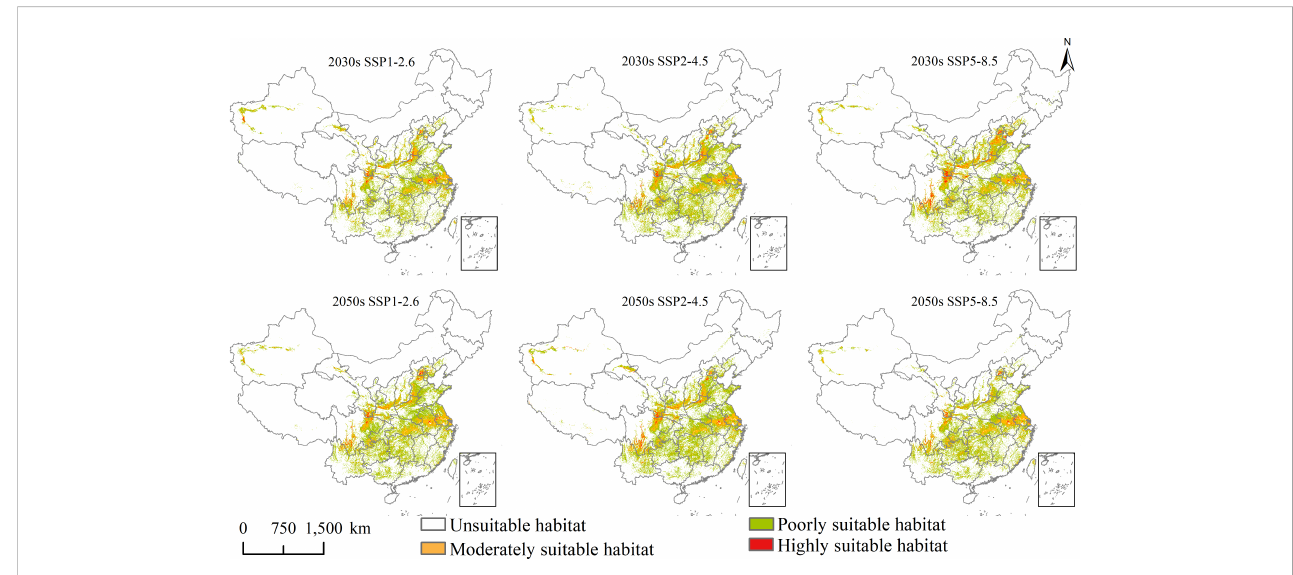
FIGURE 4 Future potential geographical distribution of Lolium temulentum under three scenarios in the 2030s and